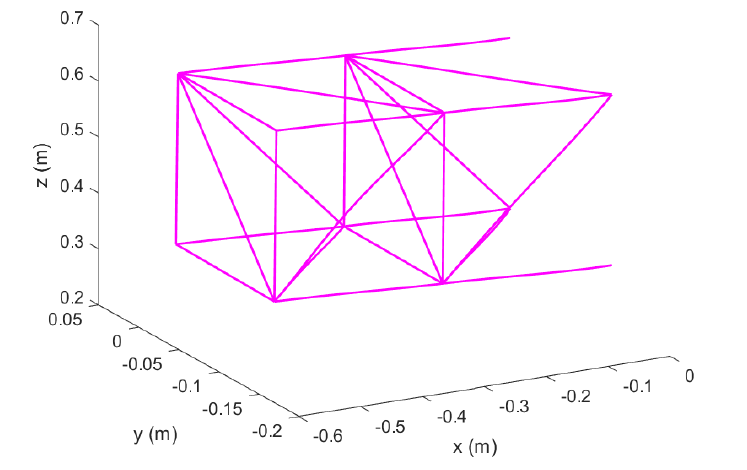
Figure 11. Mode 1 of Euler–Bernoulli Beams in Topology 1 with no hinged ends; original